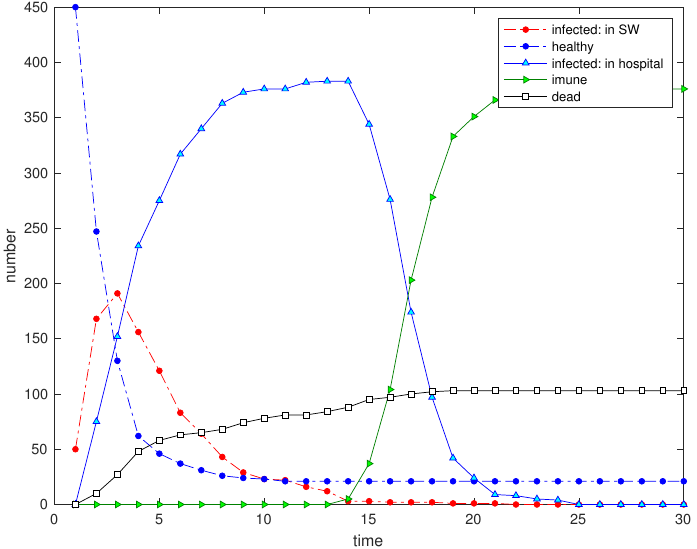
Figure 15. Scenario S 8 : Time evolution of the 5 state variables for a disturbance in the SW so that p 4 = 0.05 and p 5 = 0.02 for t ≤ 5, and p 4 = 0.01 and p 5 = 0.01 for t ≥ 6 ( N = 500, n i = 50, δ = 0.1, p 1 = 0.1, p 2 = 0.9, p 3 = 0.7, α = 2 and N h → ∞ ).